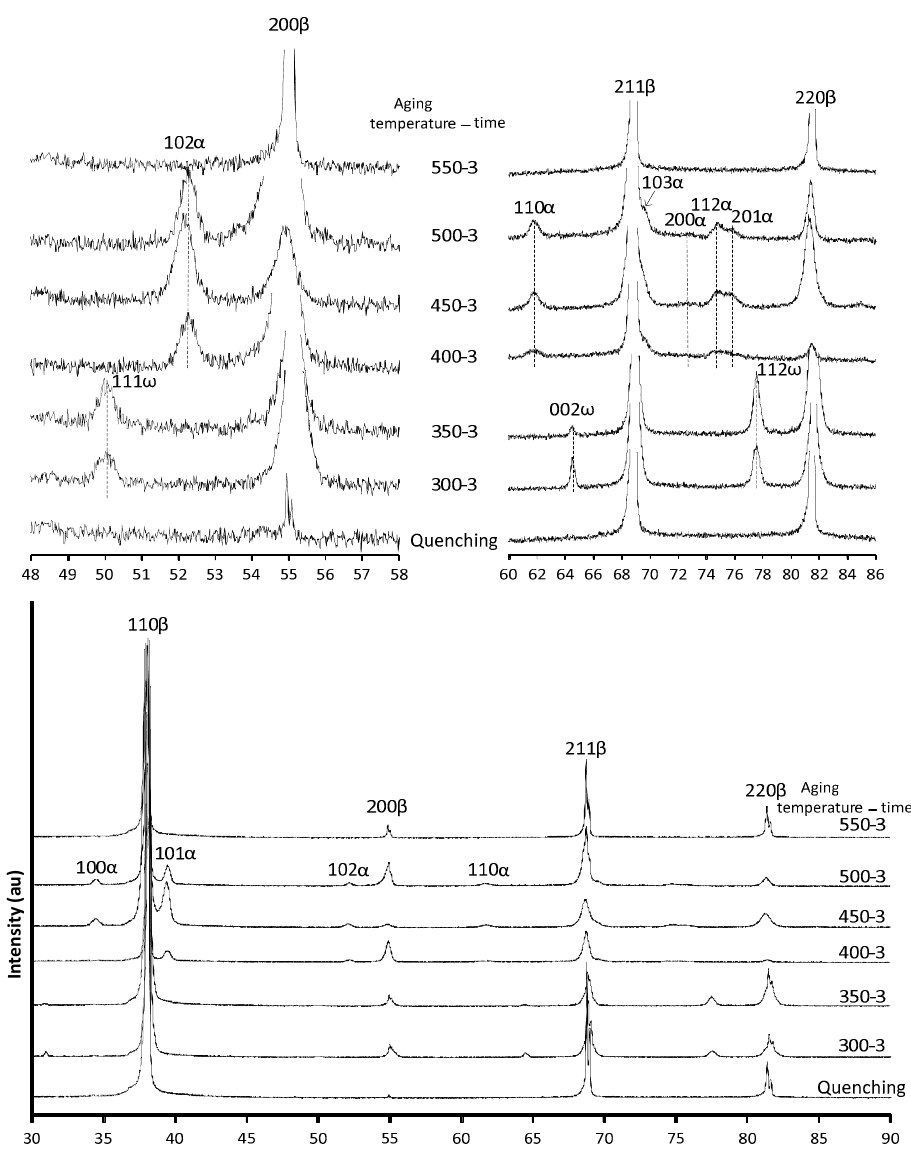
Figure 1. X-ray diffractograms analysis of Ti-18Zr-15Nb alloy after quenching and quenching followed by aging.